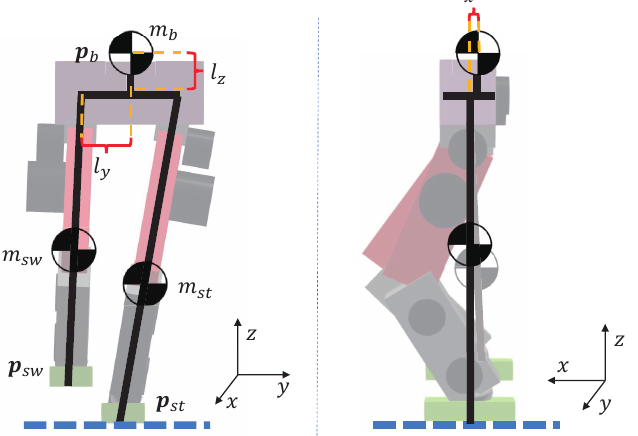
Figure 1. Three-Particle